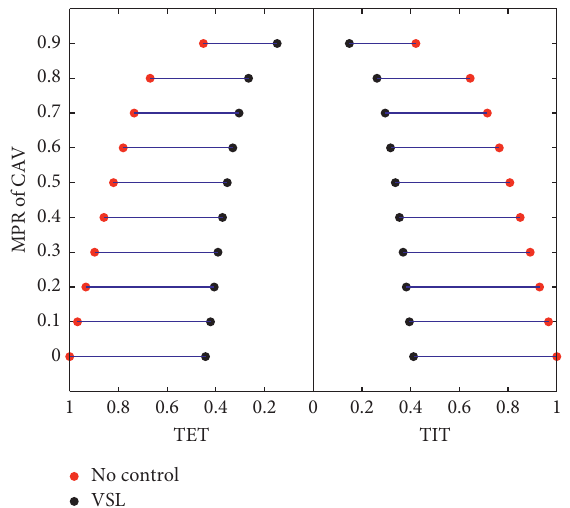
Figure 5: The safety impact of CAV-VSL control (normalization